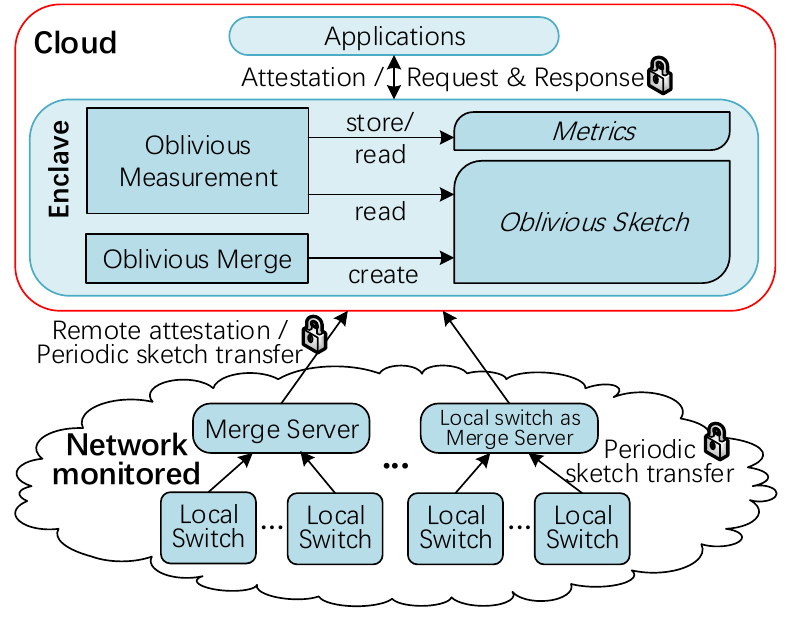
Figure 3. System overview of FO-Sketch. Trusted components are